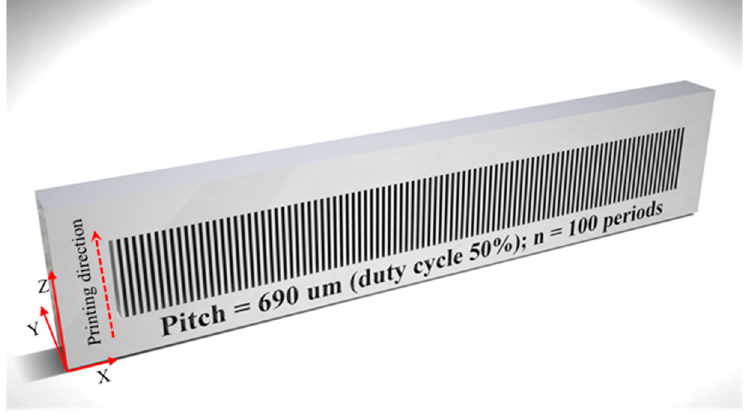
Figure 1. CAD (computer aided design) image of the 690 µm amplitude mask. The 3D files were imported to a low cost, consumer grade, DLP 3D printer (Photon 3D printer from Anycubic, Shenzhen, China), in which the resin vat had been filled with a